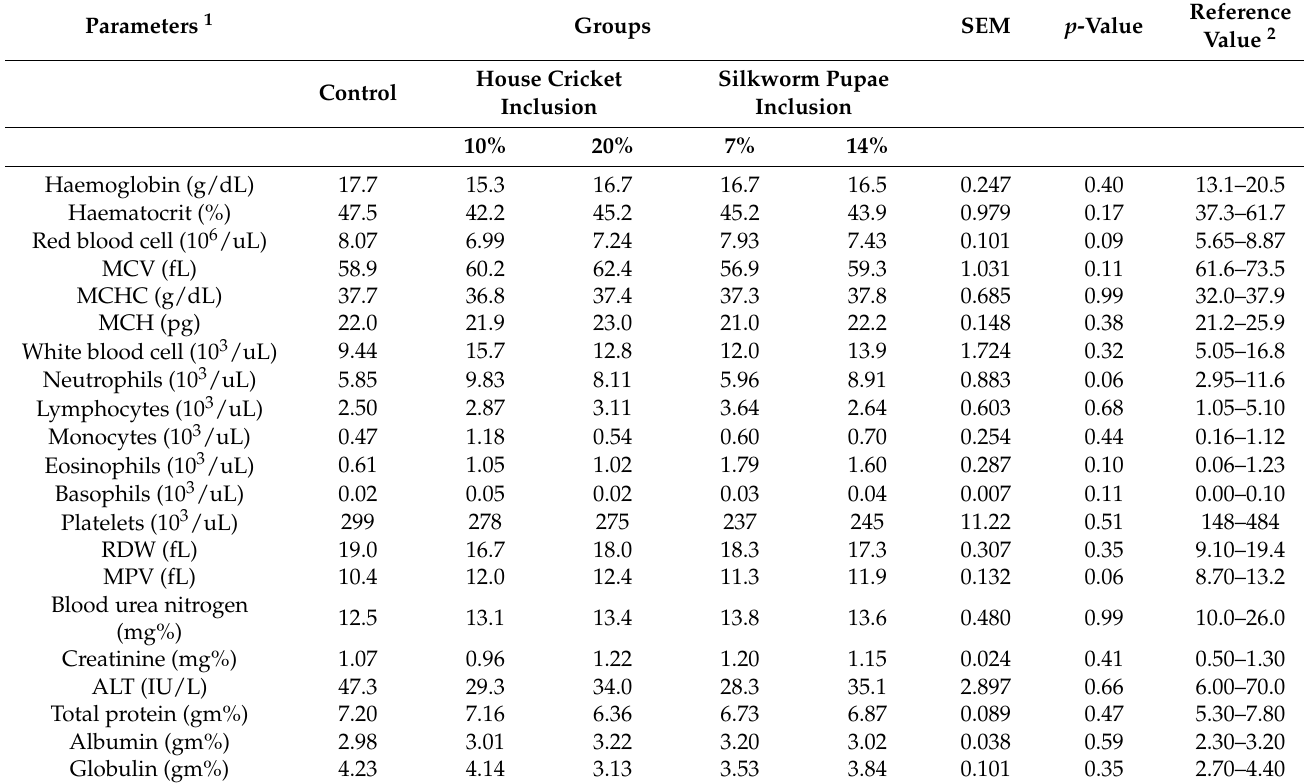
Table 2. Haematology and blood chemistry in mixed-breed dogs (2–4 years old; n = 10 per group) with or without the